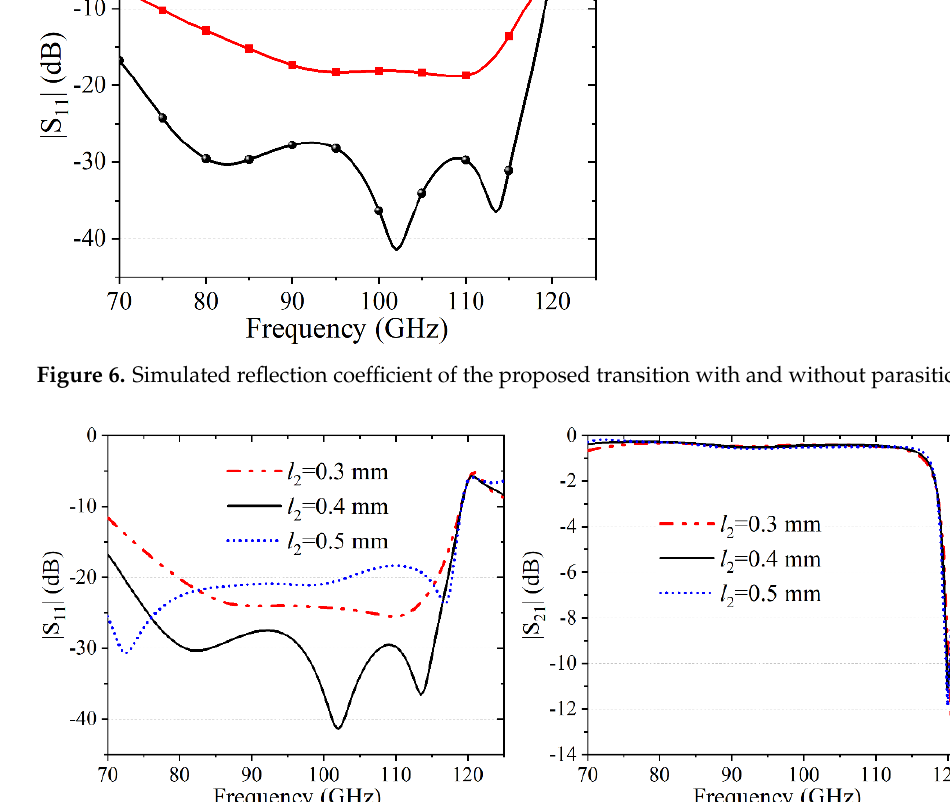
Figure 7. The simulated S-parameters with different lengths of parasitic patch.